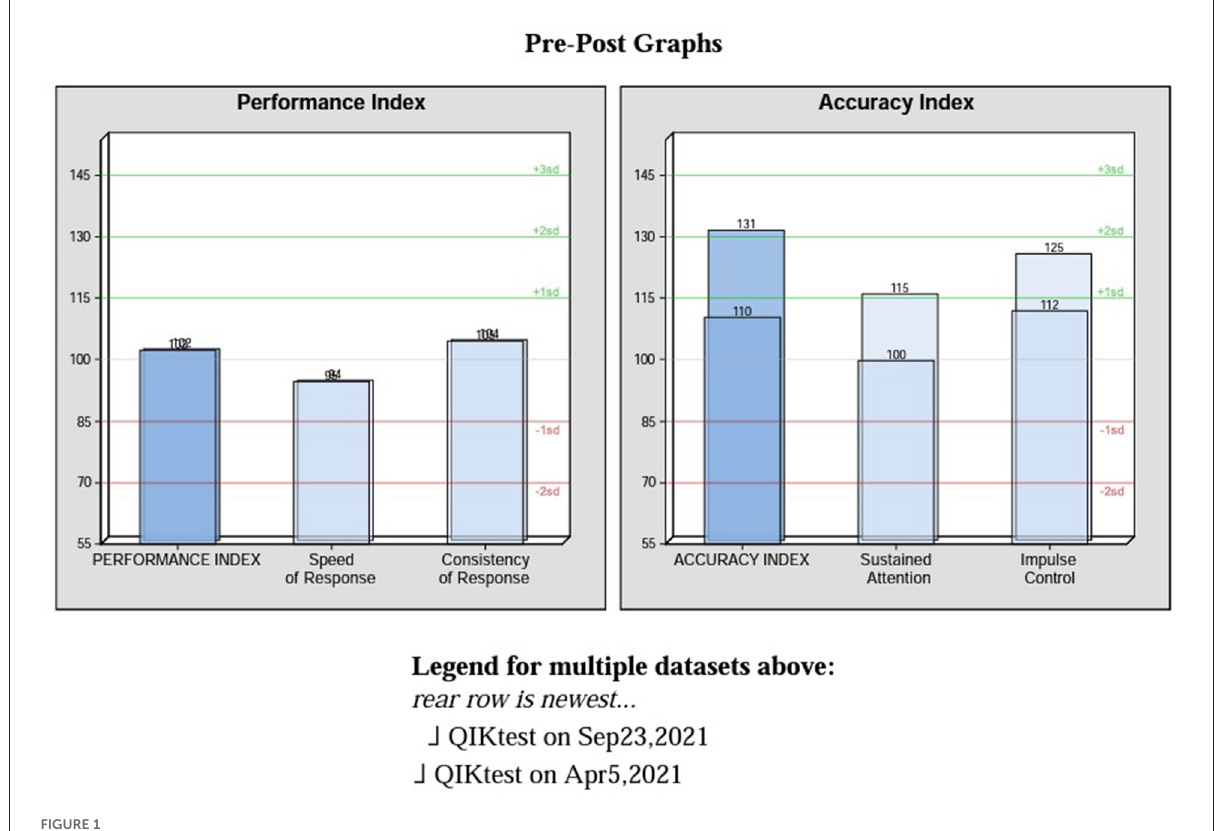
FIGURE1 Pre-post graphs on performance and accuracy indexes.